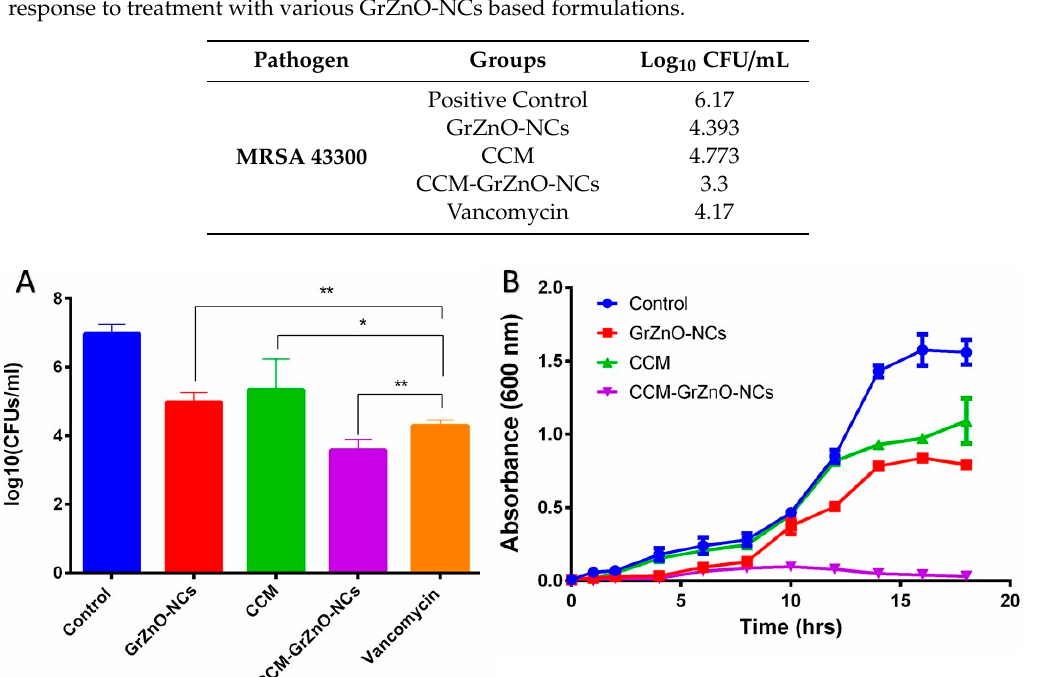
Figure 5. ( A ) Residual bacterial load assay. Bacterial counts (colony forming units) to assess residual MRSA ATCC 43300 survived after exposure to various forms of CCM-GrZnO- N.C.s. Experiments were performed in triplicates, and results are shown as mean ± S.D.; * p ≤ 0.01; ** p ≤ 0.001. ( B ) Growth kinetics analysis for M.R.S.A. when grown in the presence of di ff erent GrZnO-NCs